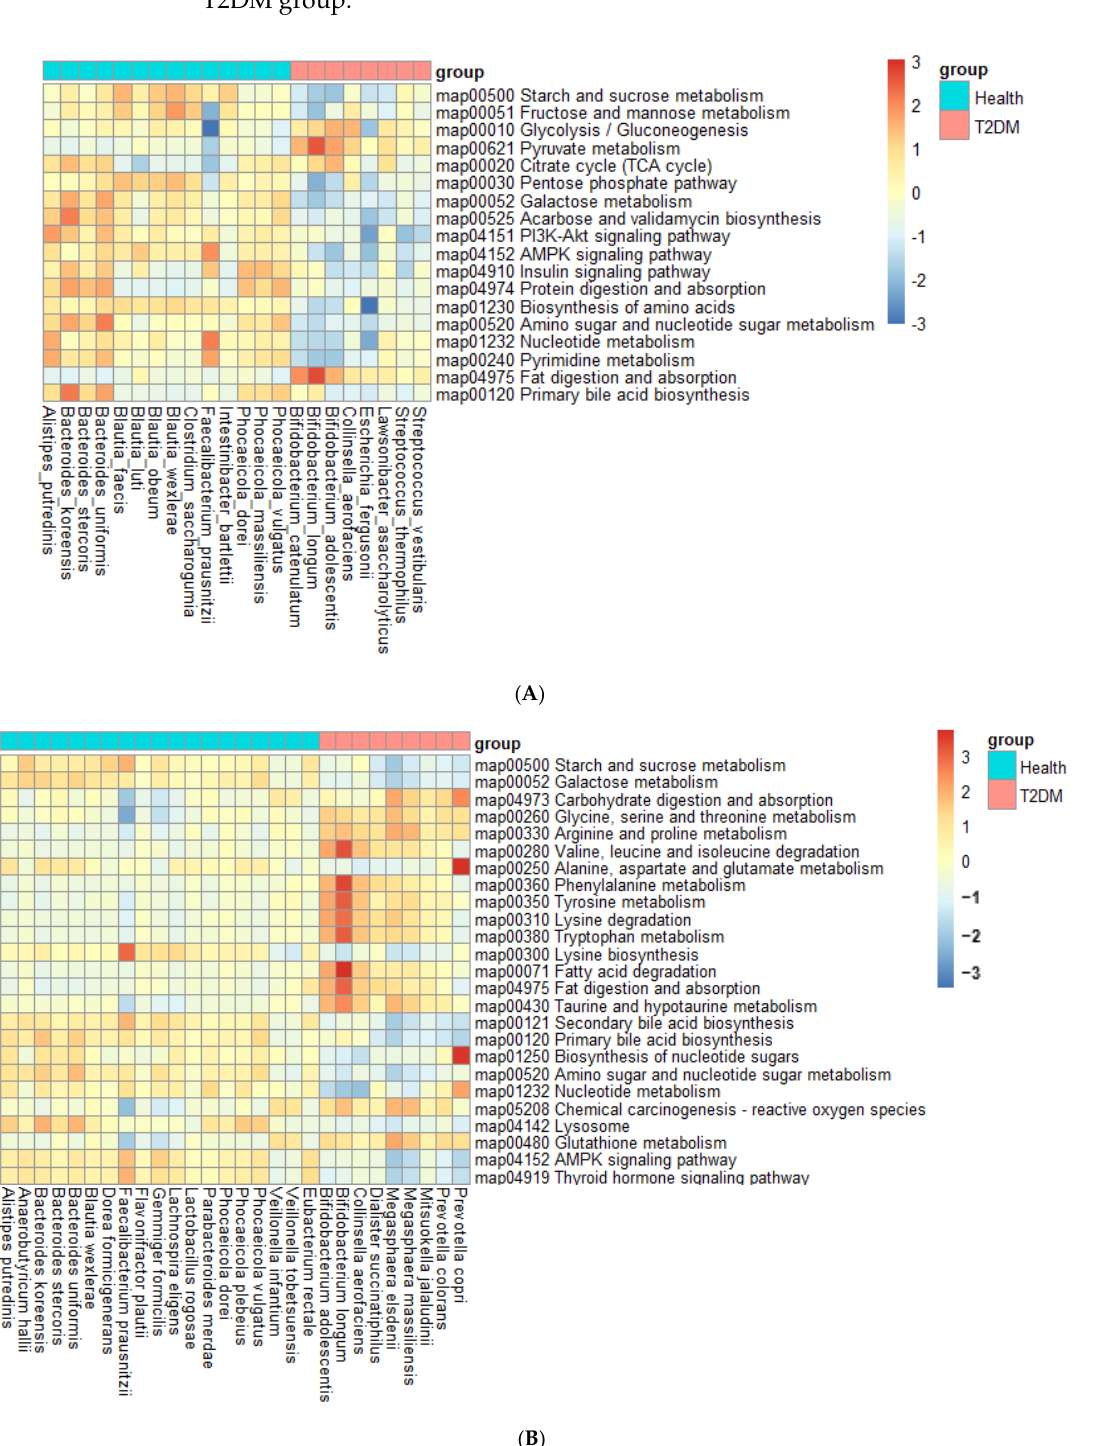
Figure 6. Metagenome functions of the primary bacteria according to each enterotype; ( A ) ET-L; ( B ) ET-P. ET-L: Enterotype Lachnospiraceae; ET-P: Enterotype Prevotellaceae.